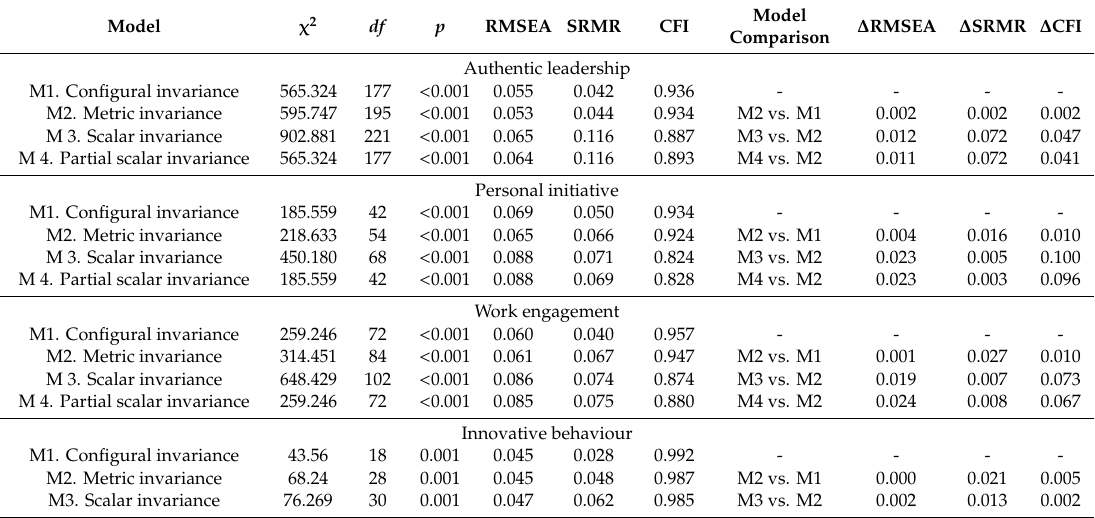
Table 1. Measurement invariance of authentic leadership, personal initiative, work engagement and innovative behaviour measures across samples of employees from the three